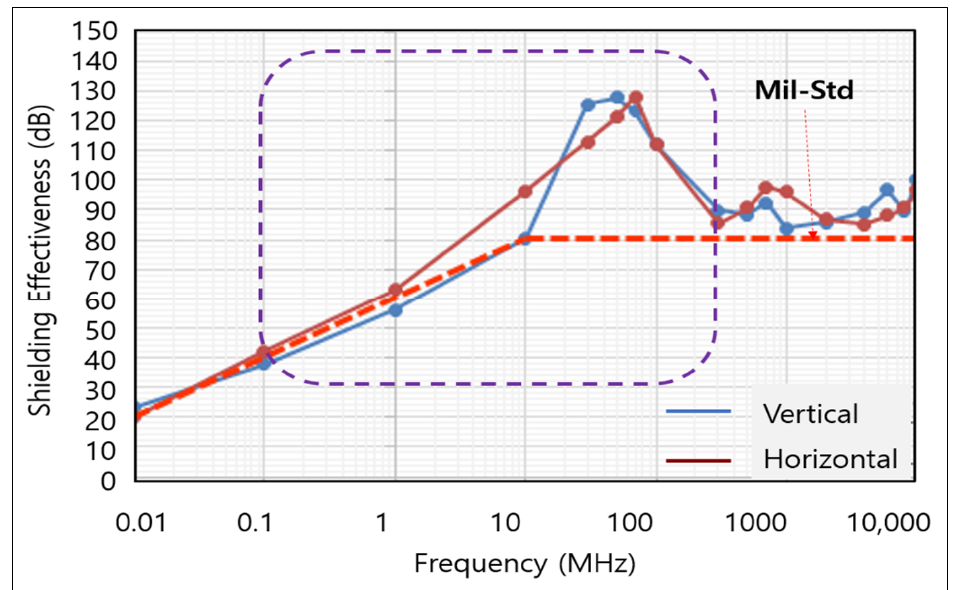
Figure 8. Shielding effectiveness of specimen #5 (W1 = 50, W2 = 20).